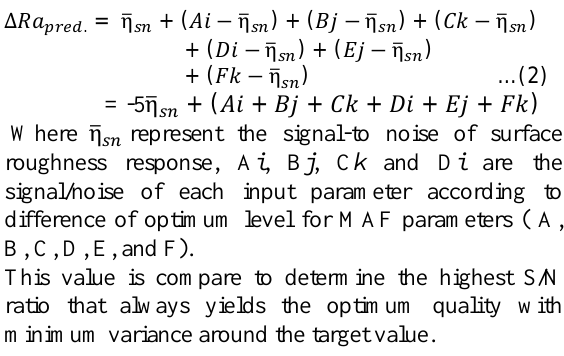
roughness. The predicted value of (S/N) ratio from Table (8), which computed by